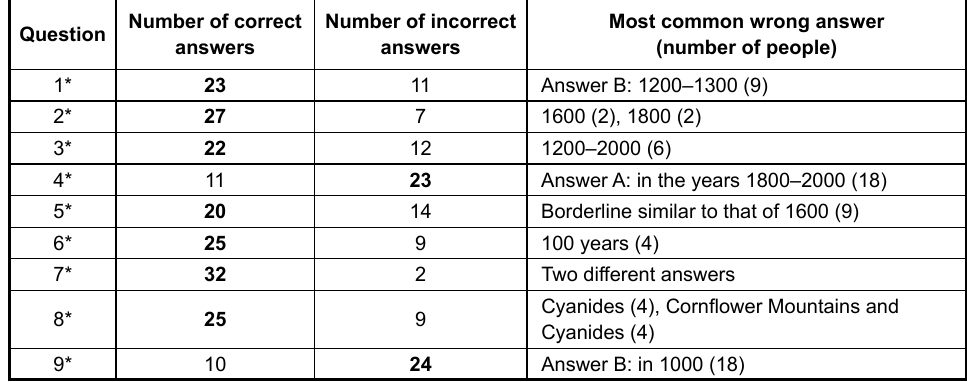
Table 3. The analysis results for responses of G2 respondents Number of correct Question